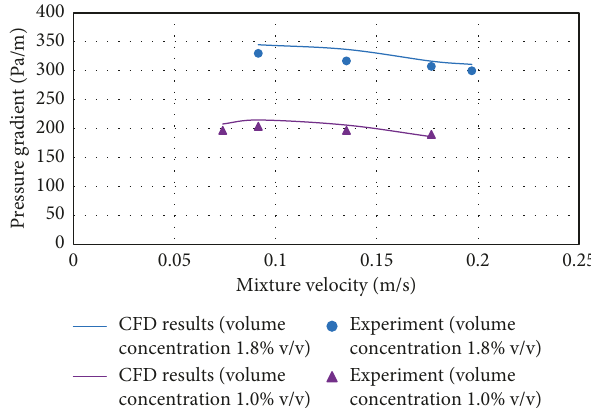
Figure 8: Comparison of simulated two-phase frictional pressure gradient at different mixture velocities and volume concentration of slurry with Ozbelge and Beyaz, 2001 (0.125m outer diameter, 0.025m inner diameter, d m � 0.23 mm) [ d m � sand particle di- ameter and C v � sand volumetric concentrations].